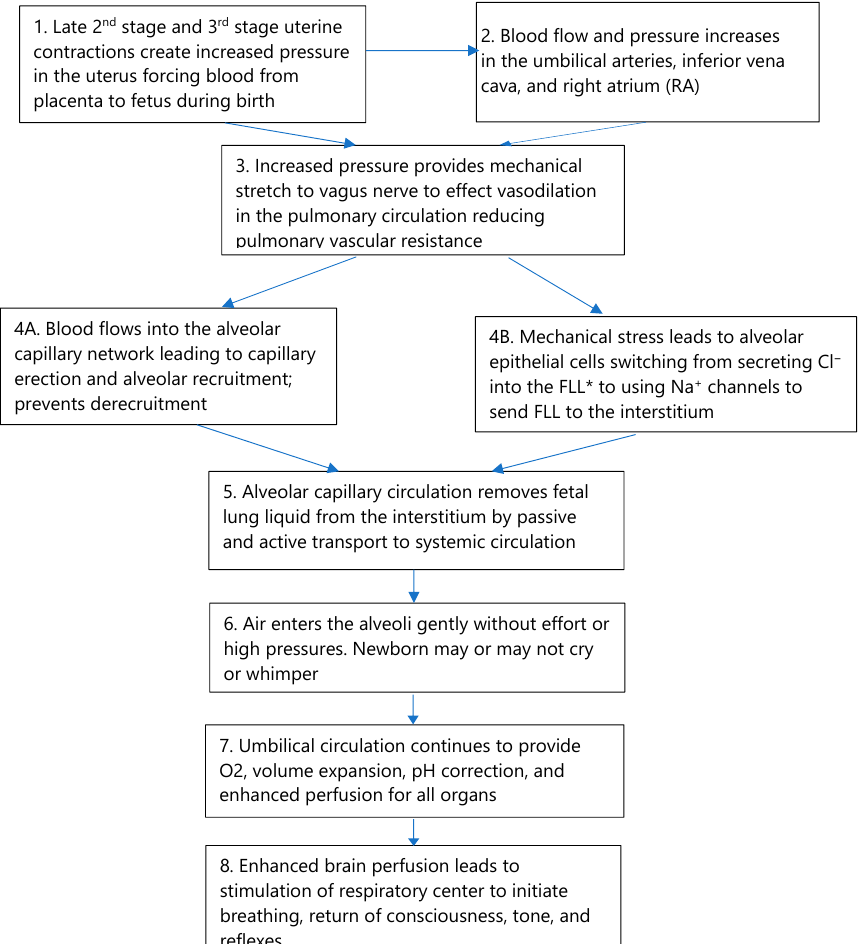
Figure 2. The blood volume model for physiologic neonatal